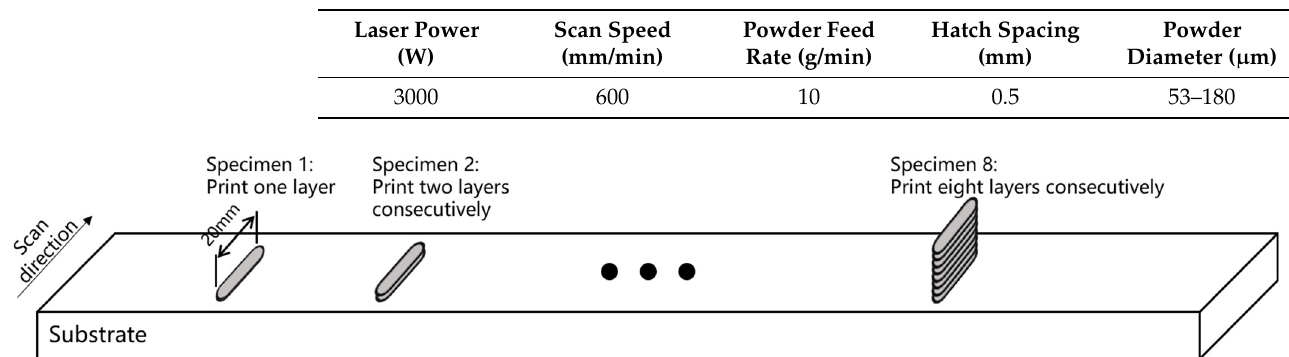
Table 1. The main process parameters of the designed LMD experiment.